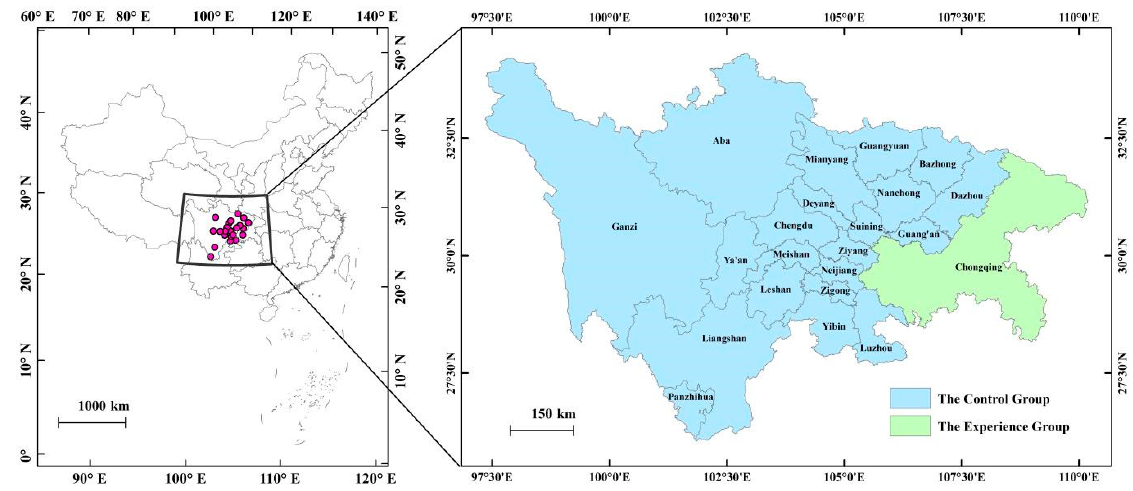
Figure 1. The Sichuan–Chongqing urban agglomeration in China.